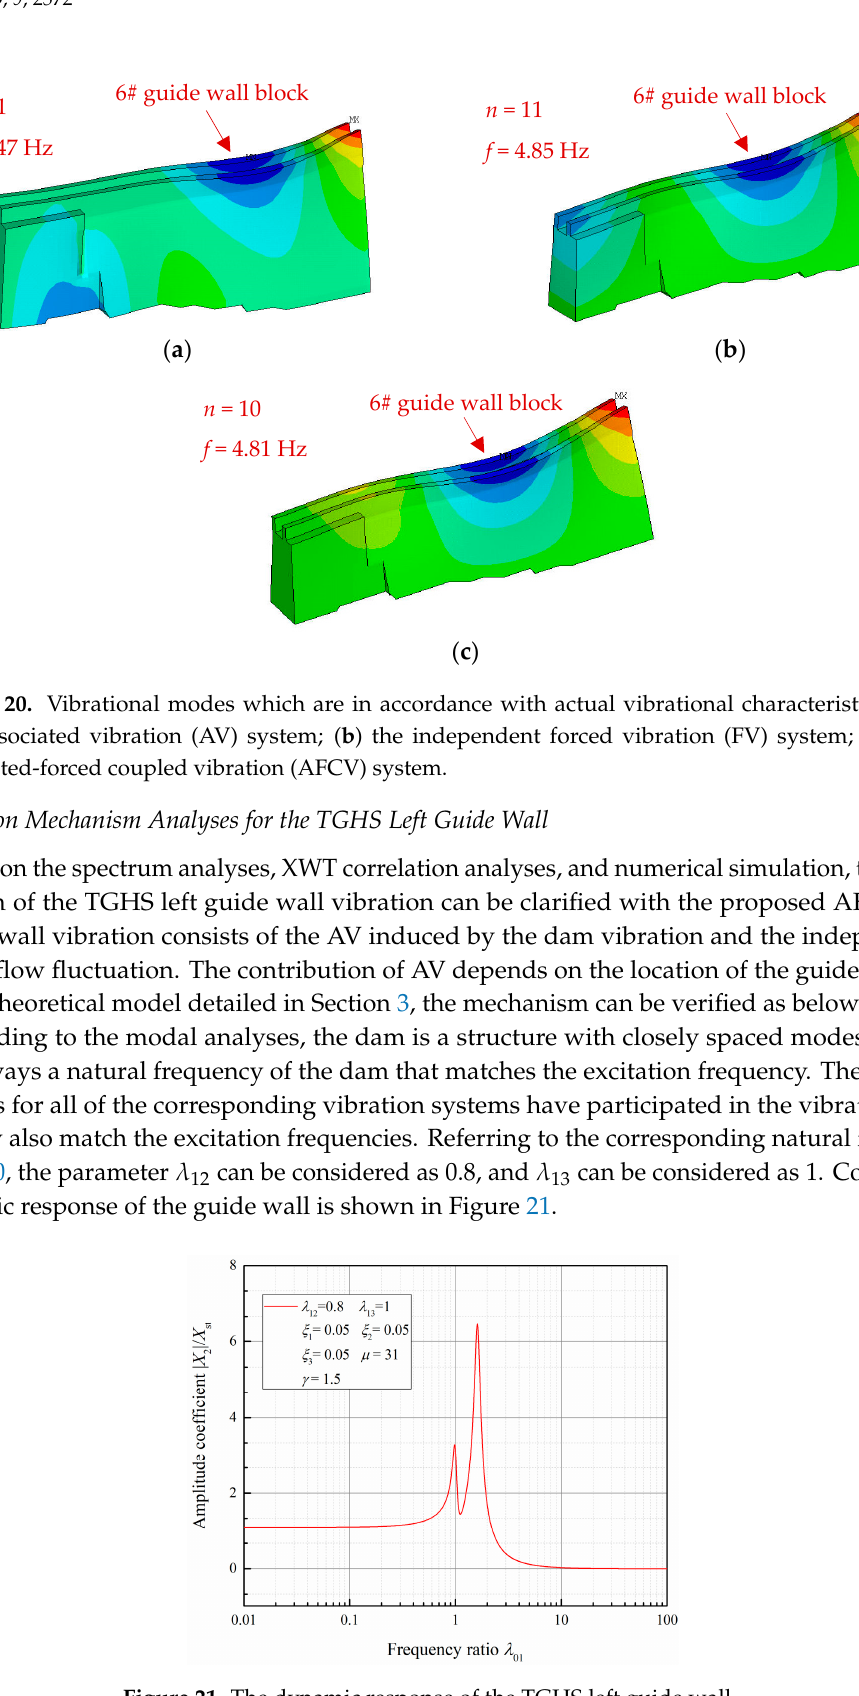
Figure 21. The dynamic response of the TGHS left guide wall.